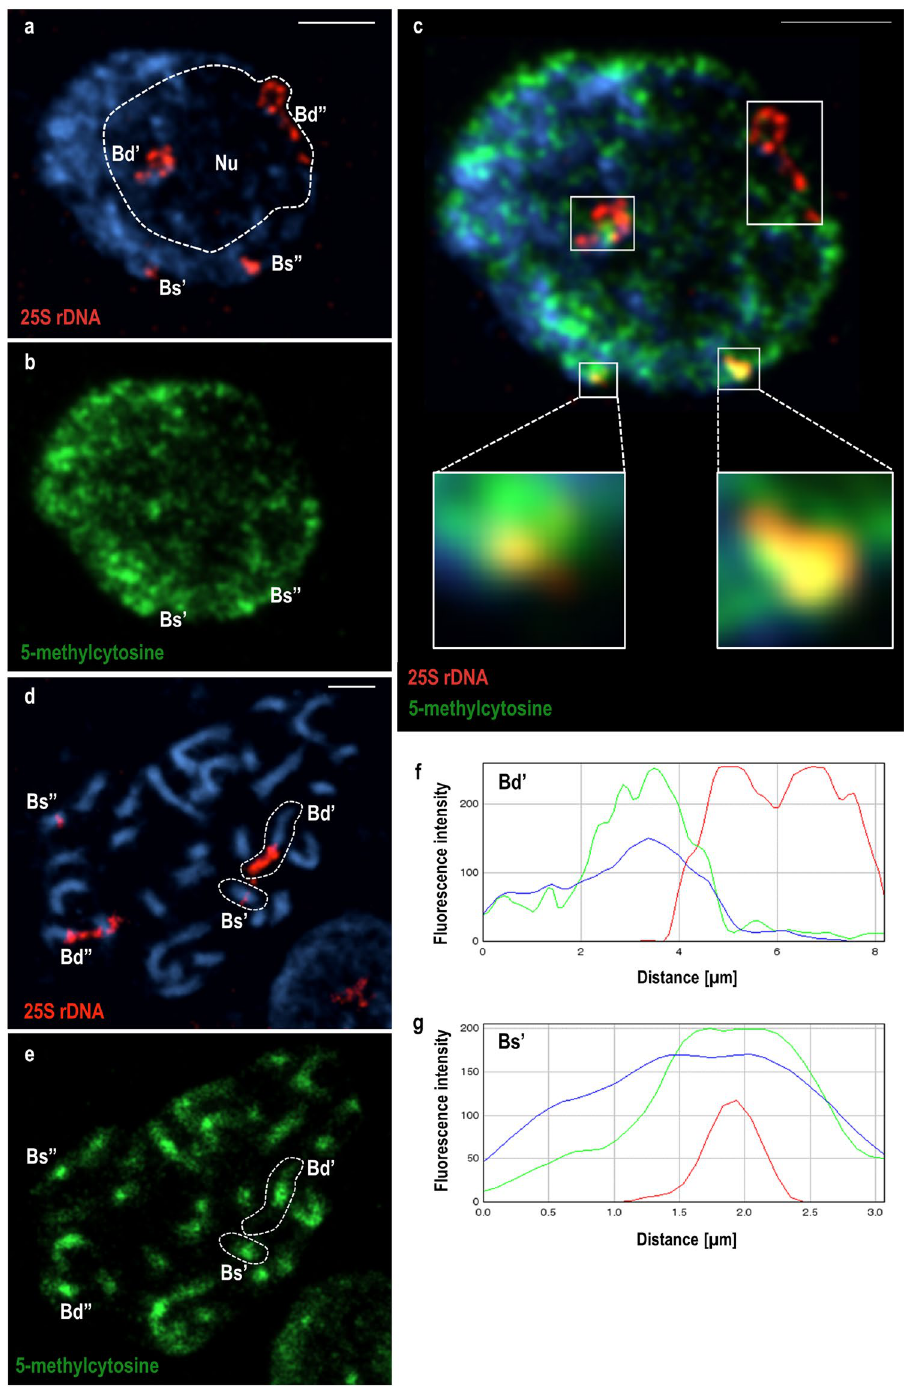
Figure 1. DNA methylation patterns of 35S rRNA genes in B. hybridum . (a) FISH with 25S rDNA (red fluorescence) as a probe in the representative interphase nucleus of B. hybridum (genotype ABR113). (b) 5-MeC immunopattern (green fluorescence) in the same nucleus. ( c) Superimposed images of nucleus after FISH with 25S rDNA (a) and signals of 5-MeC residues (b) . B. stacei -inherited 35S rDNA loci are enlarged in the insets. (d) FISH with 25S rDNA (red fluorescence) as a probe in the mitotic metaphase chromosomes of B. hybridum (genotype ABR101). (e) 5-MeC foci distribution in the metaphase complement shown on (d) . (f,g) 5-MeC foci distribution along the longitudinal axes of chromosomes Bd’ (f) and Bs’ (g) which are surrounded by dashed line on (d,e) . The blue curves denote the fluorescence intensity of the counterstain (DAPI), the green curves indicate the distribution of methylation foci. The position of the 35S rDNA loci is shown by the red curves. The length of chromosomes is shown on the x- axis in microns, while the fluorescence intensity on the y- axis is presented in arbitrary units. Nu – nucleolus. Scale bar: 5 µ